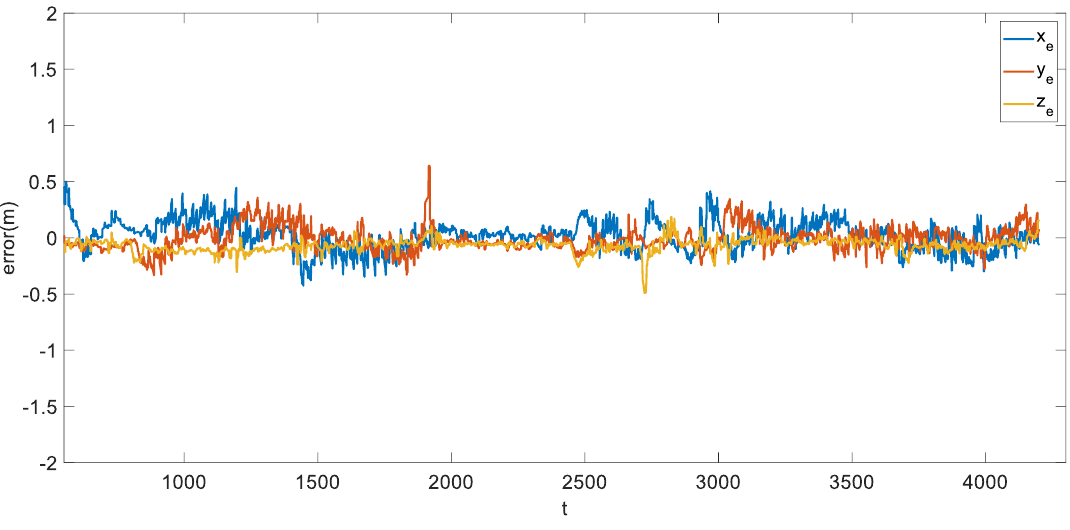
Figure 10. Comparison between the ground truth (retrieved by motion capture system) and the object position estimation.